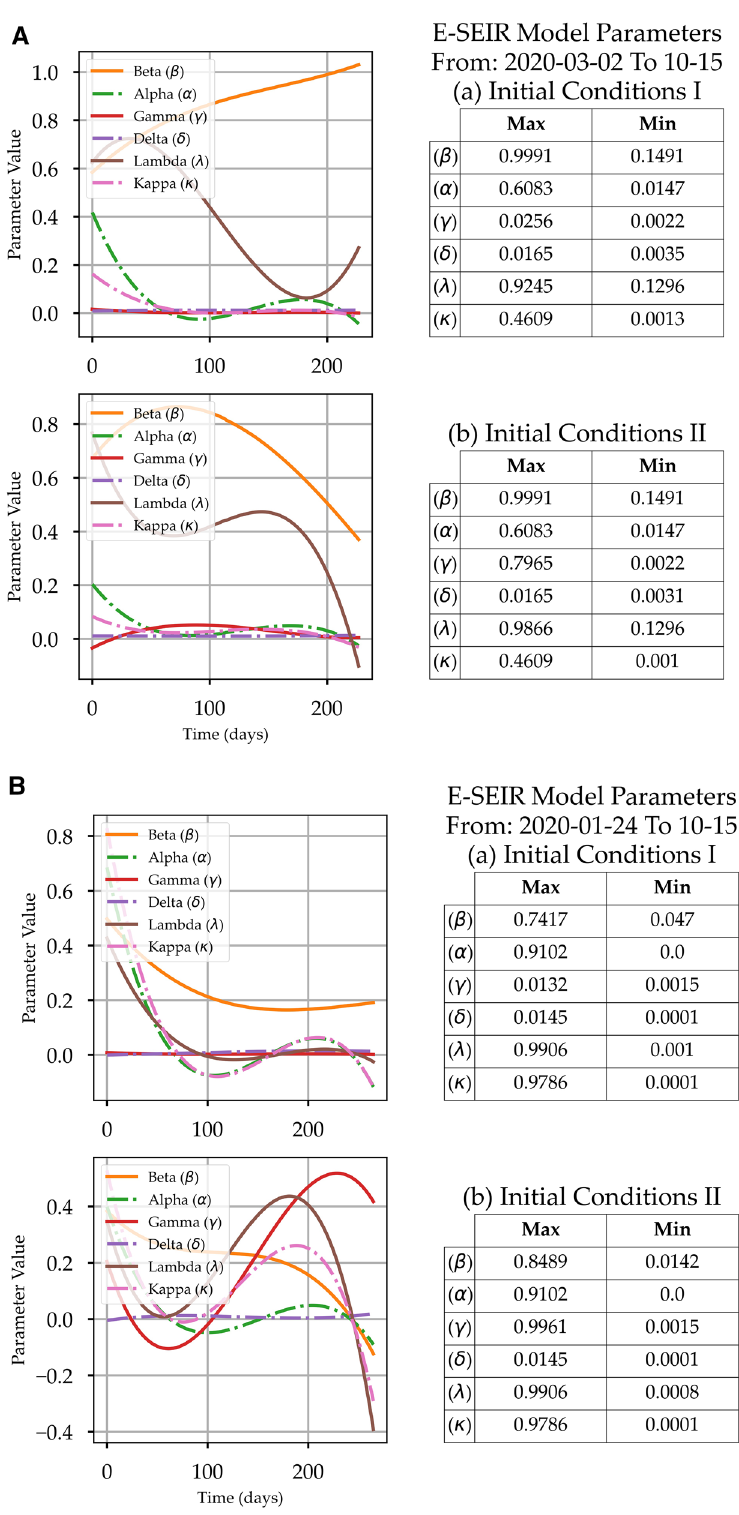
Figure 4. ( A ) The E-SEIR Models’ Solution Parameters α, β, γ, δ, λ, and κ Profiles and Maximum and Minimum Value Sets for two sets of initial conditions for Saudi Arabia. ( B ) The E-SEIR Models’ Solution Parameters α, β, γ, δ, λ, and κ Profiles and Maximum and Minimum Value Sets for two sets of initial conditions for France. ( C ) The E-SEIR Models’ Solution Parameters α, β, γ, δ, λ, and κ Profiles and Maximum and Minimum Value Sets for two sets of initial conditions for